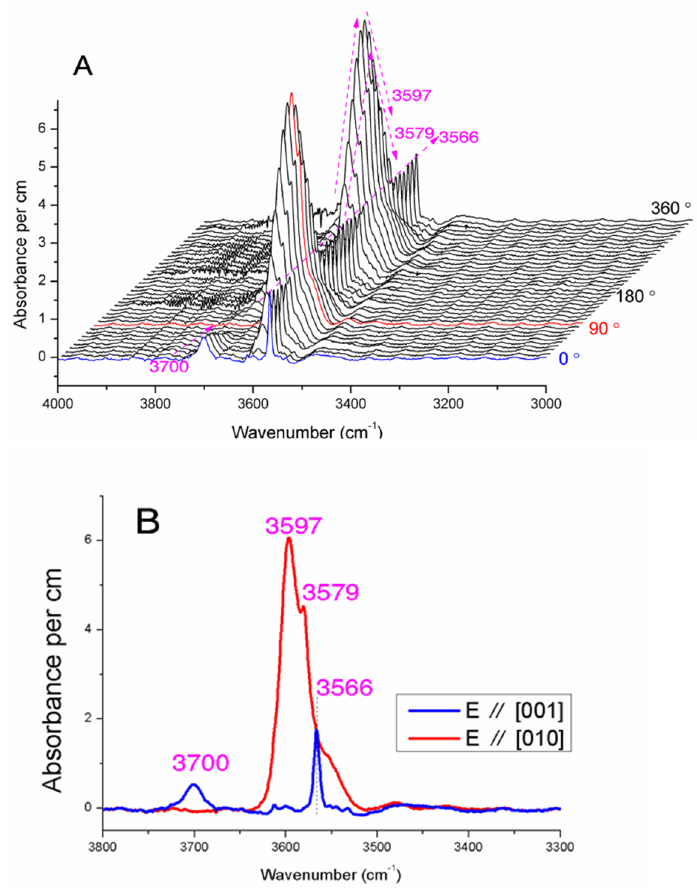
Figure 3. ( A ) IR absorption spectra of polarized IR propagating vector ⊥ (100) plane of forsterite, (E vector of light vibrating parallel to the c axis was labeled as 0 ◦ ) show the angle between IR light vibrating vector and the original directions (360 ◦ in total with a 10 ◦ interval). ( B ) The IR absorption spectra of the [001] and [010] direction.